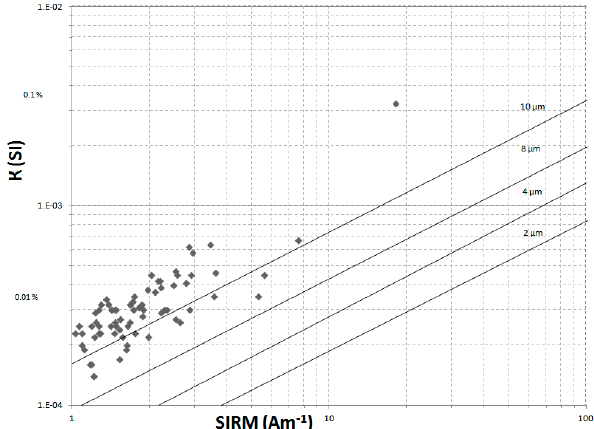
Fig. 7. Thompson’s plot (after Chaparro et al., 2004). Magnetite concentration (%) is displayed on the vertical axis (Thompson and Oldfield, 1986).